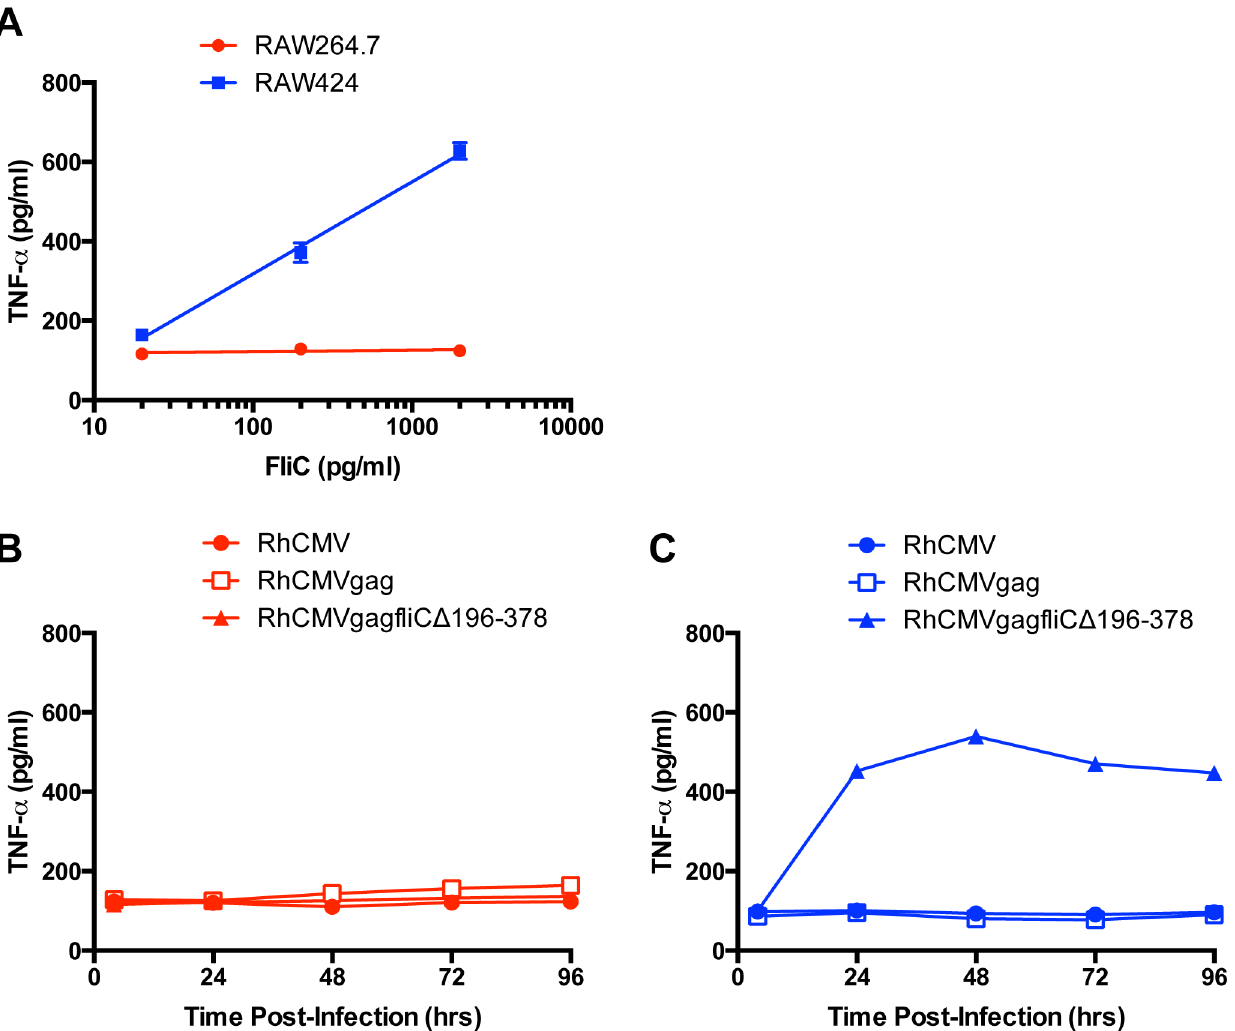
Fig 6. RhCMV-encoded Gag-FliC Δ 196 – 378 fusion protein expression kinetics. A) To determine the linear range of the TLR5 Biological Assay, RAW cells were treated with recombinant FliC, and TNF- α in the supernatant was quantified by ELISA. The graph indicates linear regression analysis. B and C) TeloRF cells were then infected with RhCMV, RhCMV gag , or RhCMV gagfliC Δ 196 – 378 and cell lysates were generated at the indicated times post-infection. The infected cell lysates were assessed for induction of TNF- α as described above on RAW264.7 cells (B) or RAW424 cells (C)